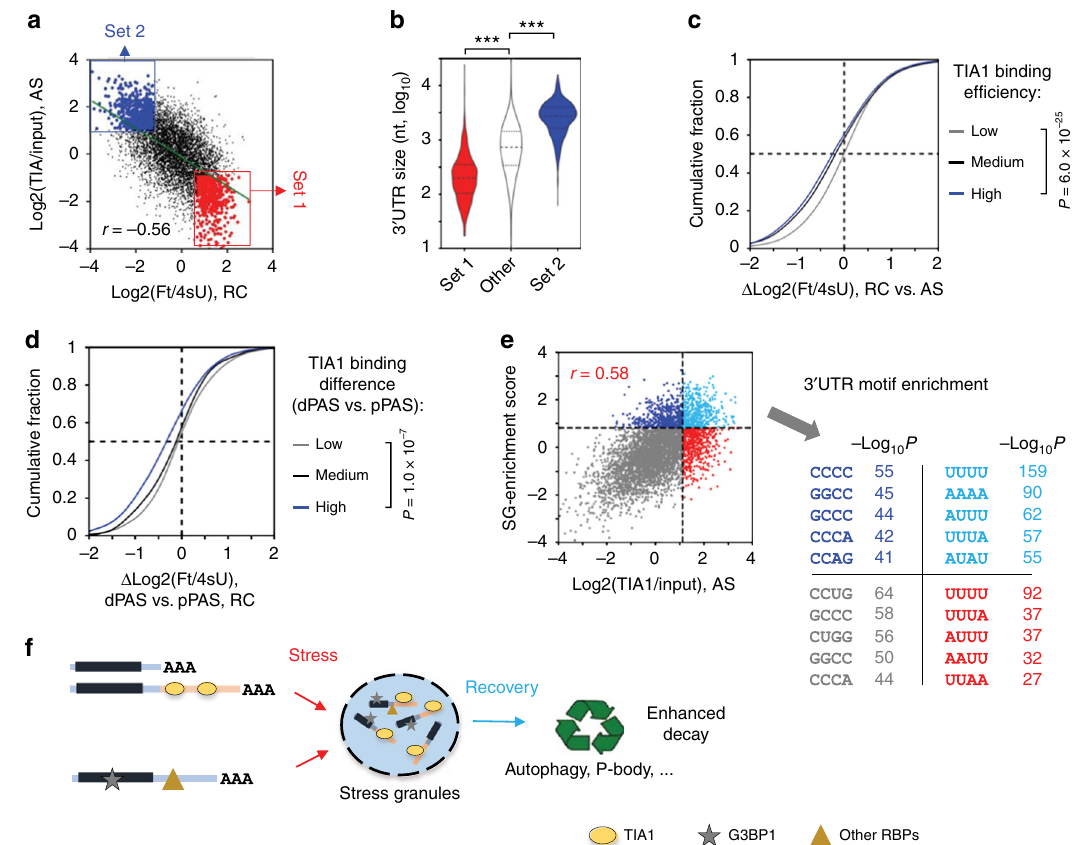
Fig. 4 TIA1 binding correlates with SG enrichment and mRNA decay after stress. a Comparison of TIA1 binding in AS cells and mRNA stability in RC cells. Each dot is a transcript with a de fi ned PAS. Red dots (gene set 1) are transcripts with low TIA1 binding in AS (bottom 20%) and high stability in RC (top 20%). Blue dots (gene set 2) are transcripts with high TIA1 binding in AS (top 20%) and low stability in RC (bottom 20%). b Violin plots of 3 ′ UTR length for three transcript sets de fi ned in a . Signi fi cance of difference between transcript sets is indicated (***, P < 0.001, Wilcoxon test). c Cumulative distribution of difference in mRNA stability between RC and AS cells ( Δ log2(Ft/4sU)) for transcripts with different TIA1 binding ef fi ciencies. High, medium, and low TIA1 binding transcripts were top 1/3, middle 1/3, and bottom 1/3 based on log2(TIA1/Input), respectively. d Cumulative distribution of difference in stability between APA isoforms in RC ( Δ Log2(Ft/4sU, RC), dPAS vs. pPAS) for genes with low (gray), medium (black), or high (blue) difference in TIA1-binding between APA isoforms ( Δ Log2(TIA1/Input, AS), dPAS vs. pPAS). e Left, scatter plot showing comparison of TIA1 binding and SG enrichment under AS. Each dot represents a mouse gene and its homologous human gene. SG-enrichment score is based on association of transcripts with G3BP1 in the SG core, and TIA1 binding is log2(TIA1/Input) in AS cells. Right, enriched tetramers in the 3 ′ UTRs of genes from different groups (as colored in the scatter plot). f A model summarizing TIA1 binding to 3 ′ UTR isoforms, SG association during stress, and mRNA decay during recovery. Some transcripts